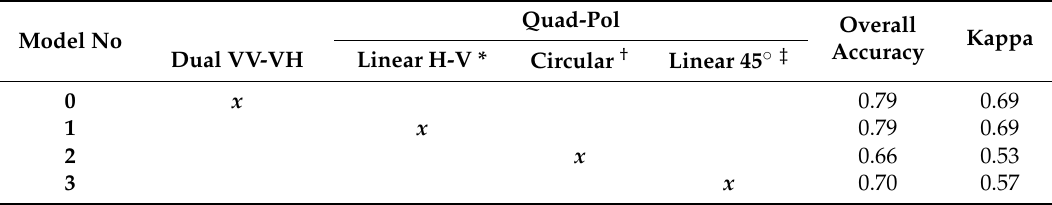
Table 6. Classification accuracy measures using as input dual-pol vs. quad-pol with different polarization